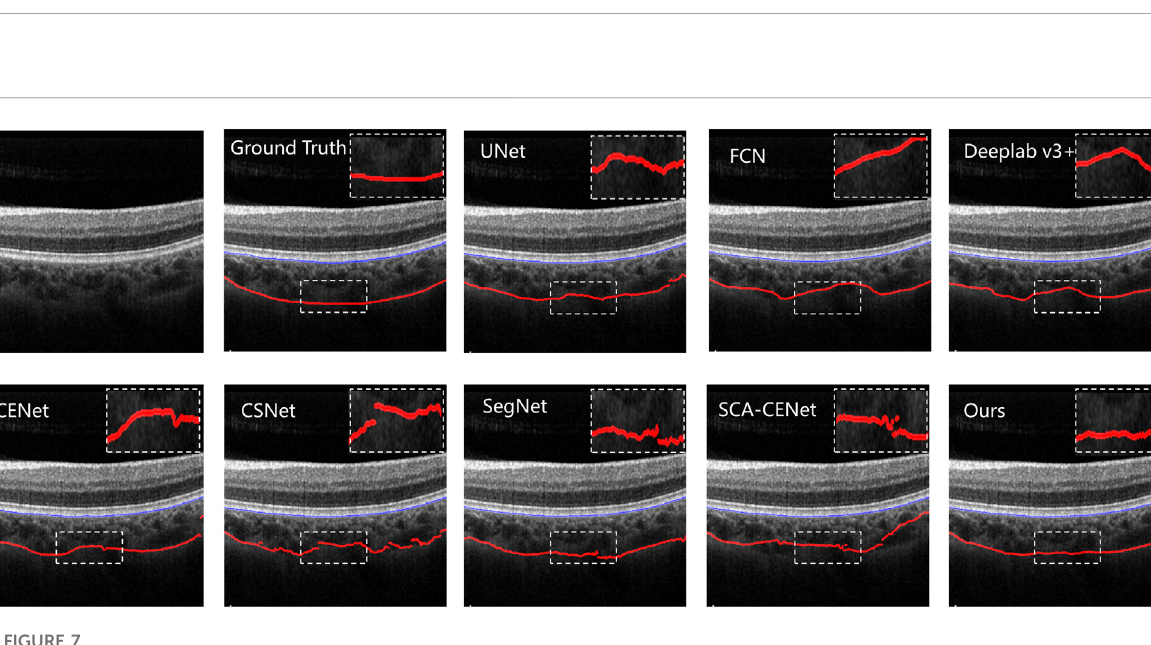
Frontiers in Cell and Developmental